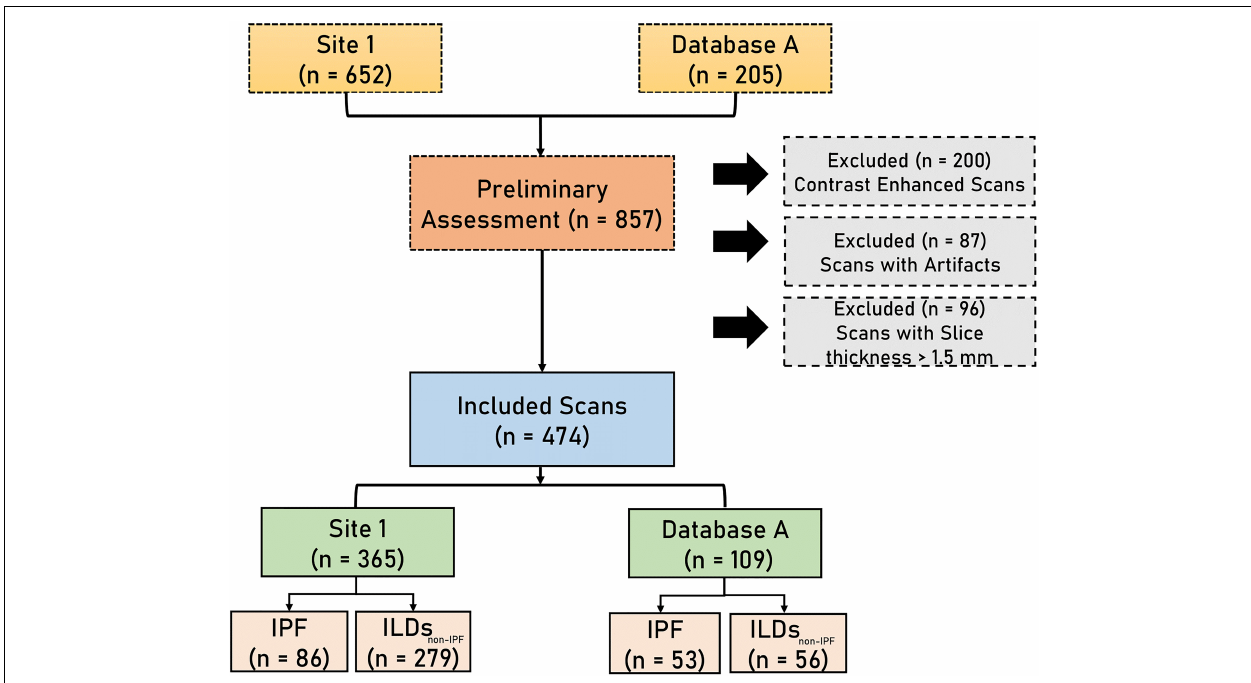
FIGURE 1 | The flowchart diagram shows the patient selection process. IPF, idiopathic pulmonary fibrosis, ILDs non − IPF , non-IPF interstitial lung